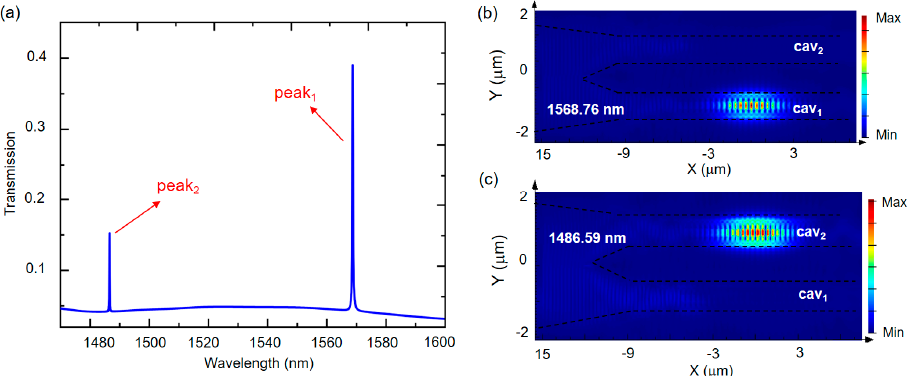
Figure 6. ( a ) Transmission spectrum of the cascaded PCNCs. Peak1 and peak2 show the basic modes of cav 1 and cav 2 . ( b , c ) The corresponding major electromagnetic field distribution of PCNCs (x ‐ y plane with z = 0). plane with z =